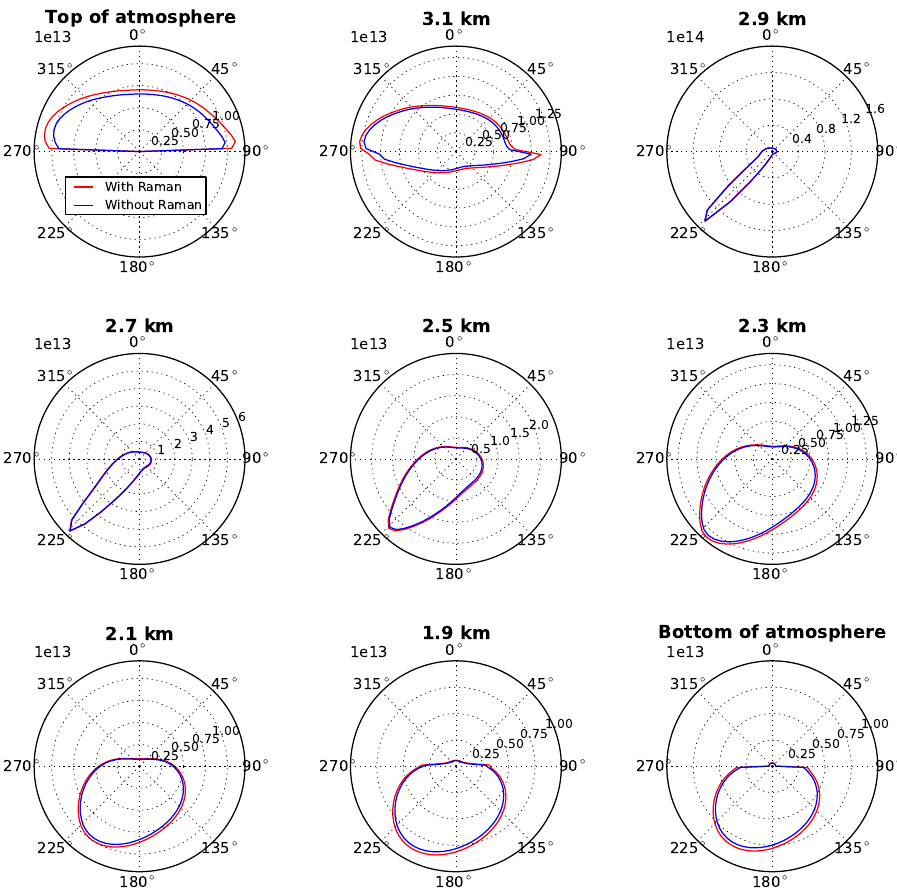
Fig. 7. The radiance [photons/(scm 2 nmsr)] in the solar principal plane for various altitudes. The solar principal plane is defined to be the plane laid out by the incoming solar beam with azimuth angle 8 0 = 180 ◦ and radiation scattered in the forward direction, 8 = 0 ◦ . The polar angle gives the direction of the radiation in the plane. A polar angle of 0 ◦ gives radiation travelling in the zenith direction. The sun is incident at 45 ◦ . The atmospheric conditions are as in Fig. 6 with a cloud of optical depth of 10 located between 2 and 3km. Note that the scales on the various plots